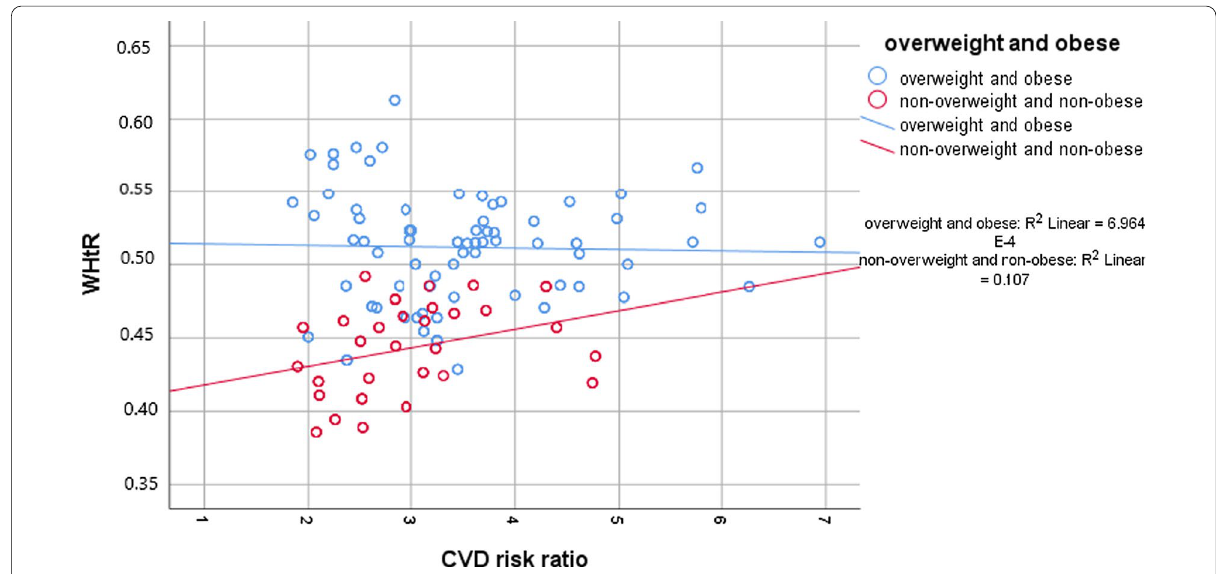
Fig. 4 Correlation between WHtR and CVD risk ratio stratified by overweight and obesity